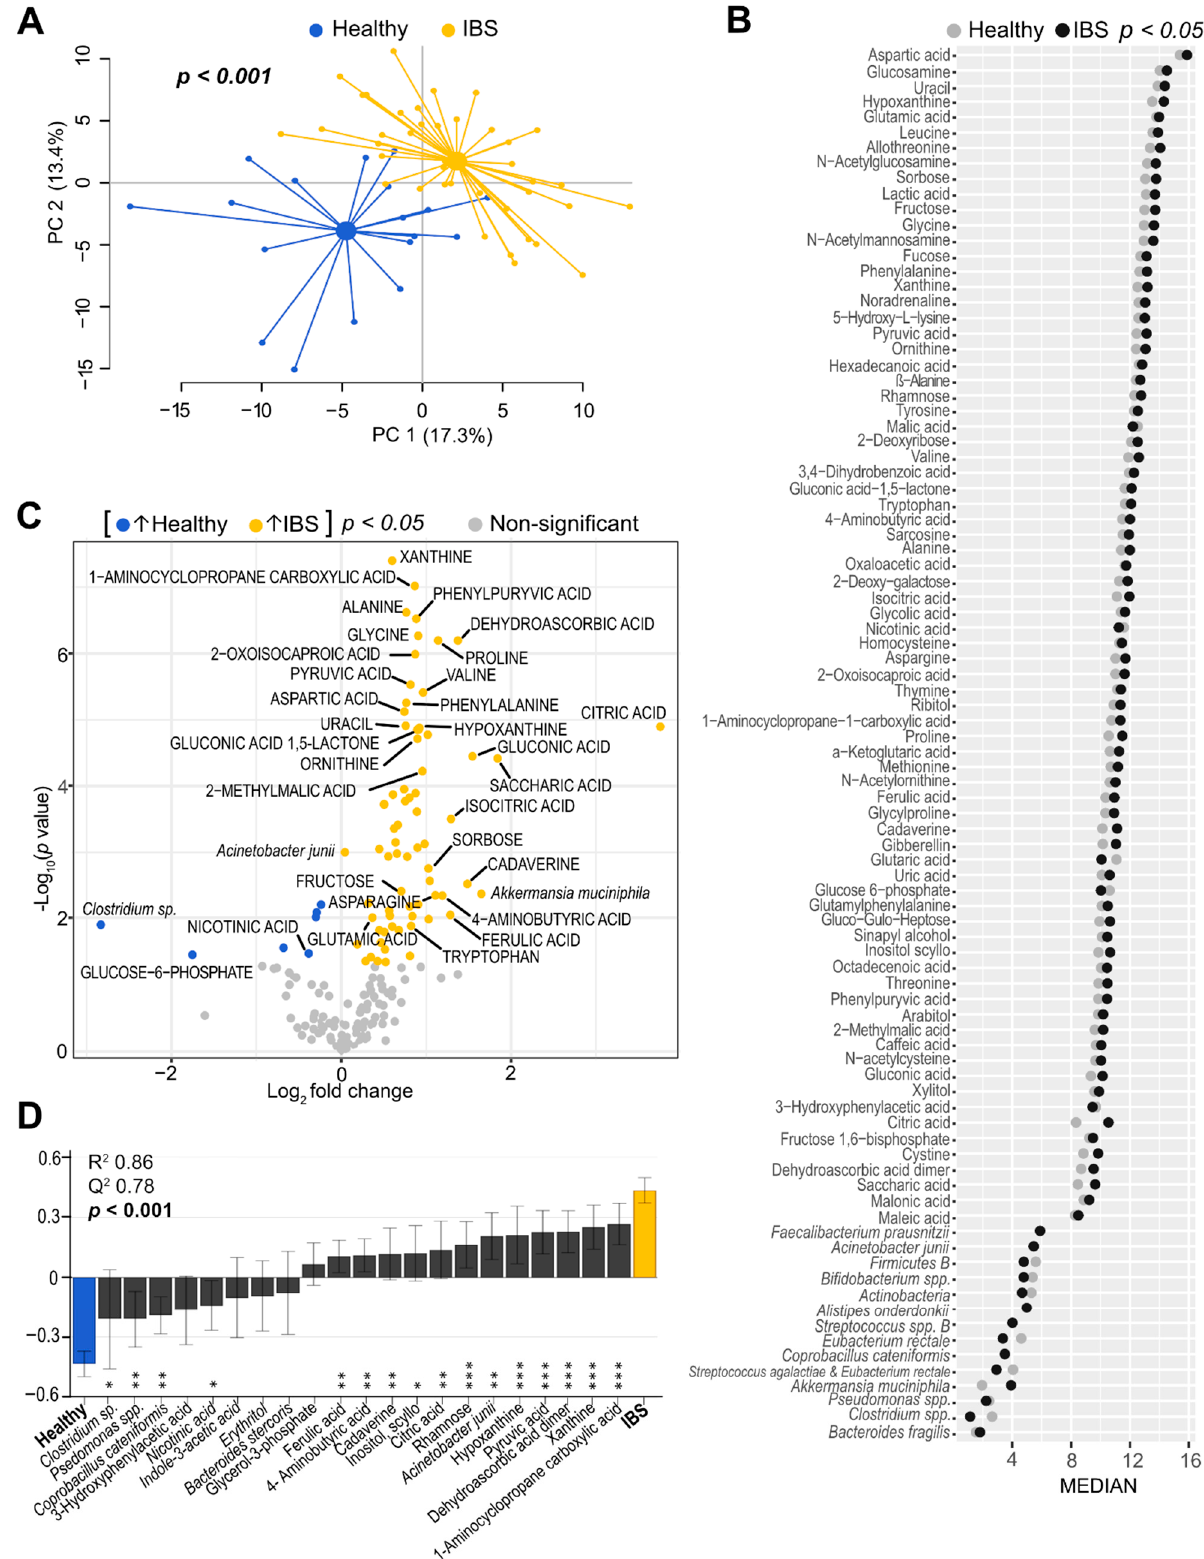
Figure 1. Faecal microbiota and metabolite profiles of IBS patients and healthy subjects. ( A ) Principal component analysis (PCA) score scatter plot based on faecal bacteria and metabolites showing IBS patients ( n = 40, yellow dots) and healthy